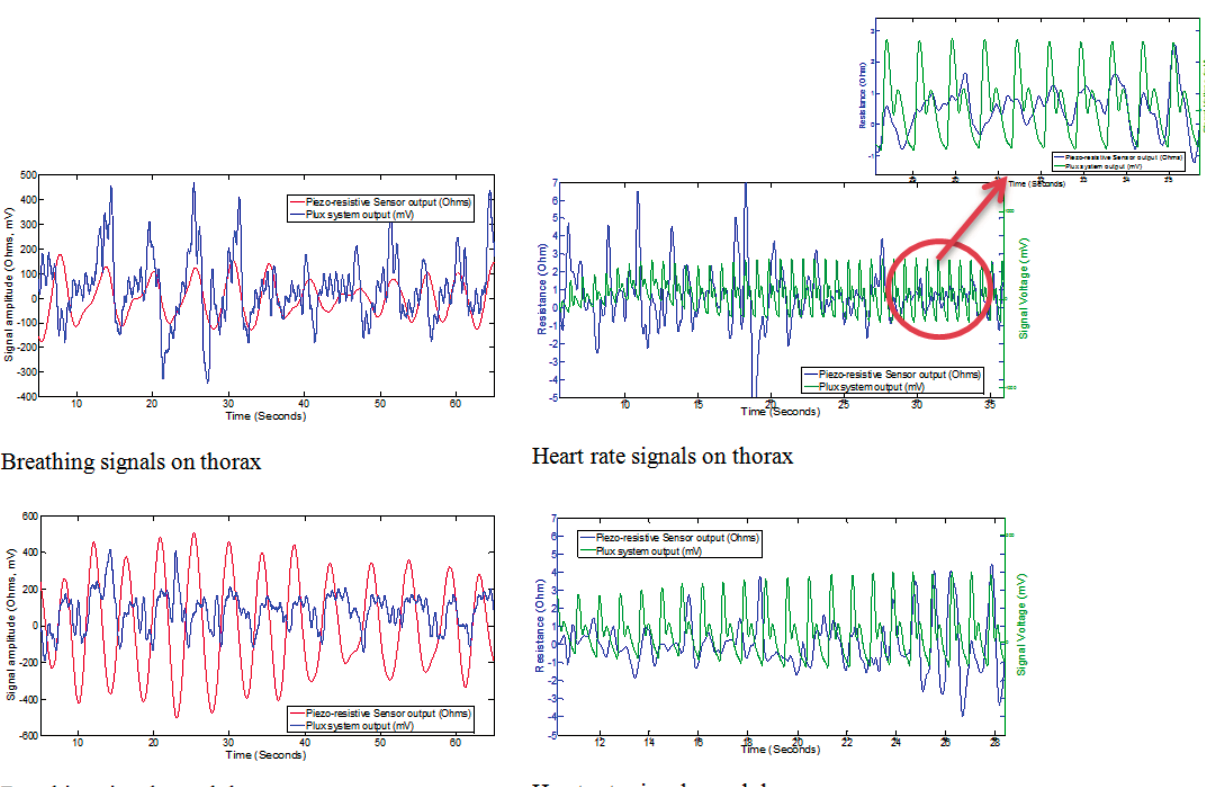
Figure 6. Results from prototype of safety